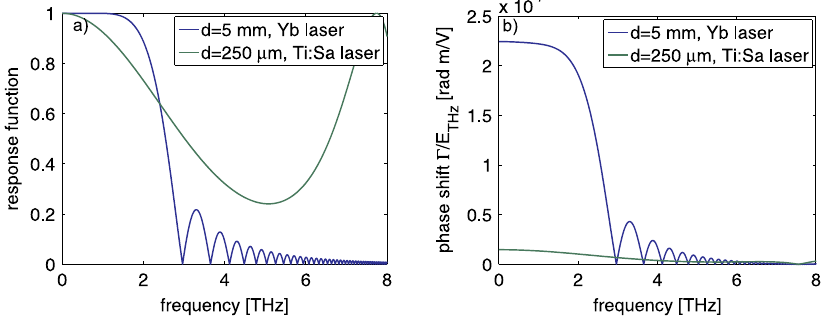
FIG. 6. (a) Response function for Yb laser pulses in a 5 mm (blue curve) and Ti:Sa laser pulses in a 250 (cid:3) m thick GaP crystal (green curve). (b) The phase shift, i.e., the overall efficiency, is almost 20 times higher for Yb laser (blue curve) than for Ti:Sa laser (green